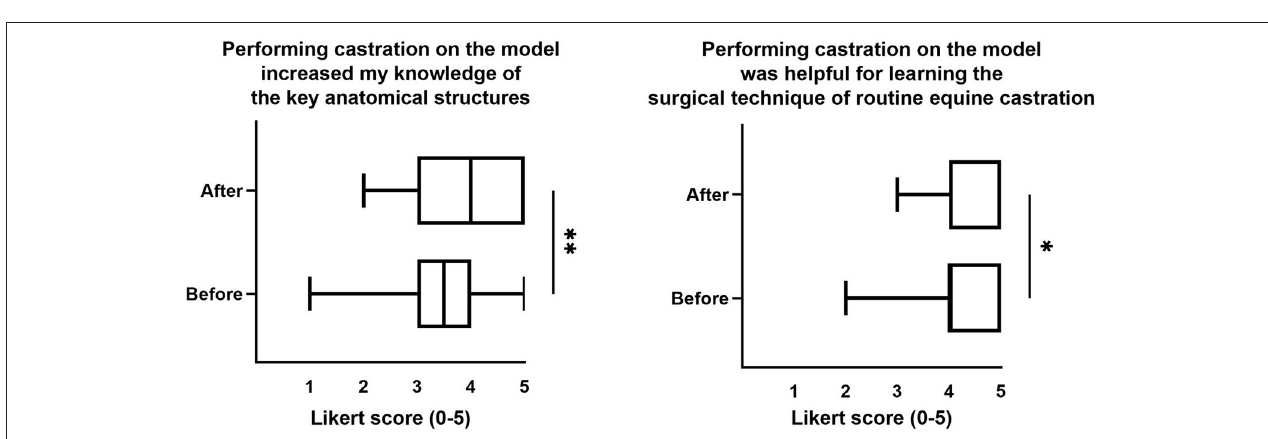
FIGURE 5 | Significant differences in Likert score model ratings from students before vs. after live horse castration. Heading is the text taken from the survey prompt. Data are presented as median and min-max. Statistical analysis performed with Kruskal-Wallis test with Dunn’s multiple comparisons post-hoc test. * p < 0.05 and ** p <